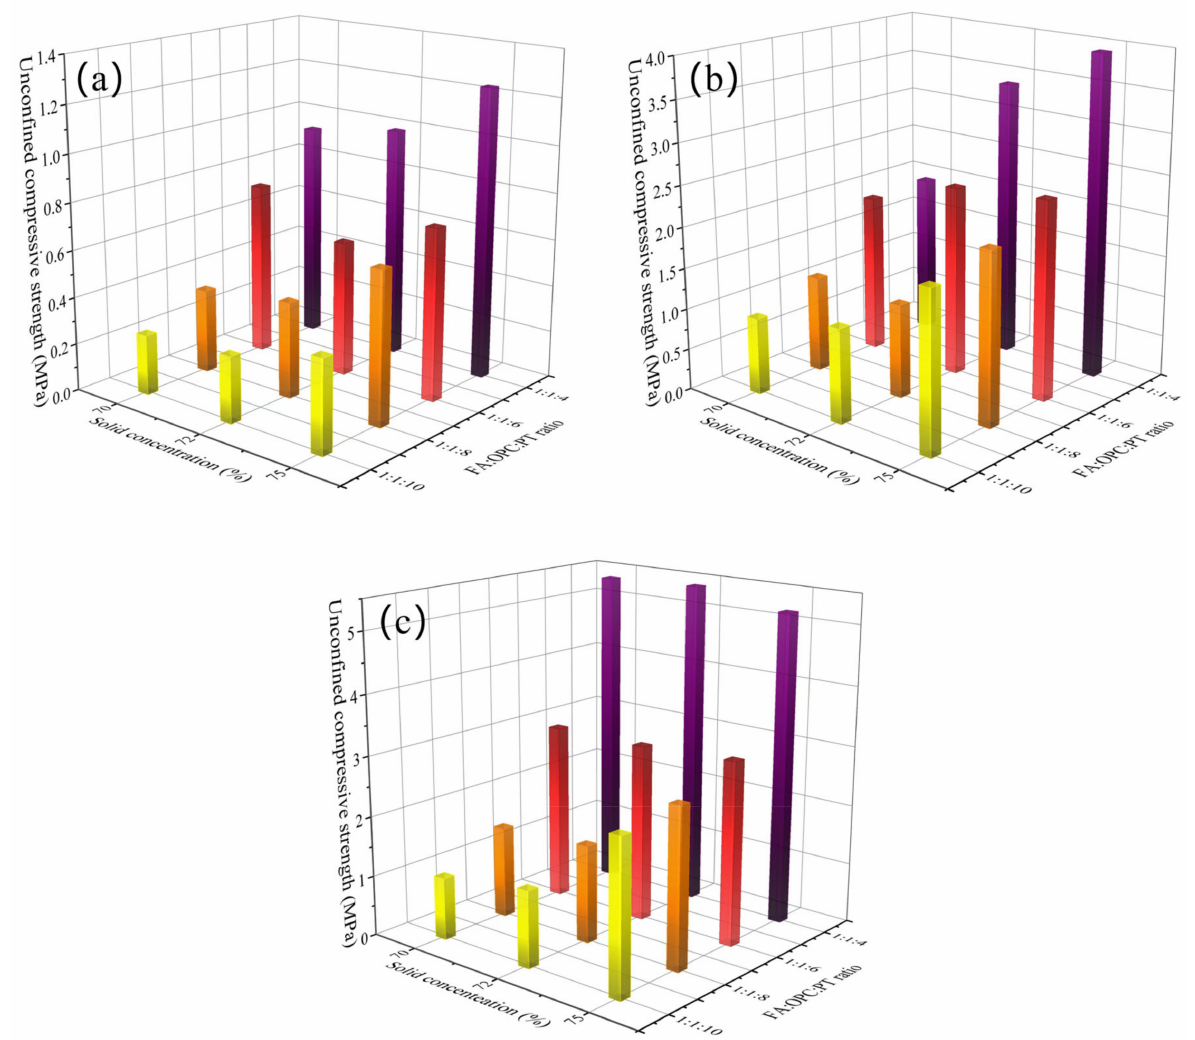
Figure 4. Variation of the UCS of backfill specimens with FA:OPC:PT ratio and solid concentration (using FA and OPC as the binder): ( a ) 7 days; ( b ) 14 days; ( c ) 28